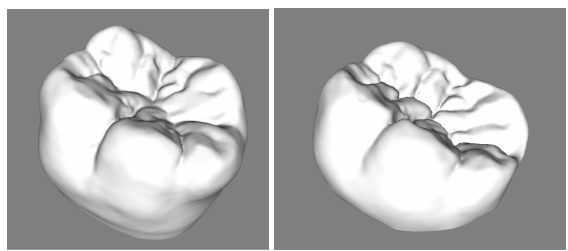
Figure 5. Crowns modelled digitally by default (left) and after reshaping (right) on multidirectional odontotomic sectioning of teeth: with radial semi-planes and equally spaced parallel planes, which automati- cally slice studied teeth (Figure 6).